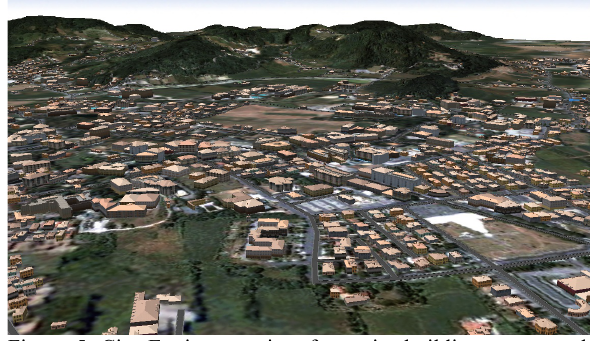
Figure 5. City Engine user interface: city buildings generated with procedural